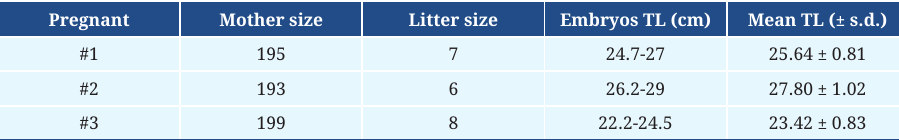
TABLE 1 | Uterine fecundity and size of embryos of Blacktip Sharks, Carcharhinus limbatus , captured in June 2004 in Rio Grande do Norte, Northeastern